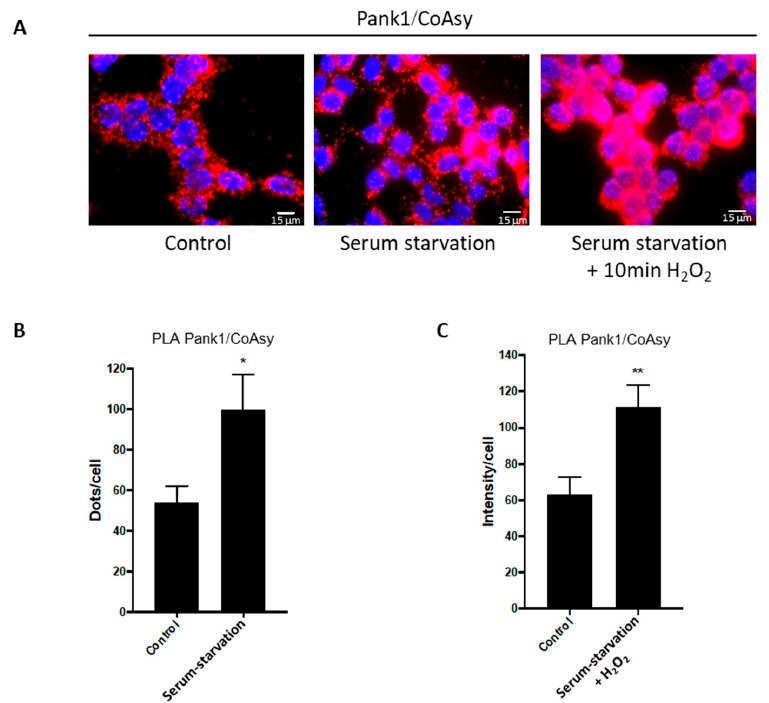
Figure 3. Serum starvation and treatment of HEK293/Pank1 β cells with hydrogen peroxide (H 2 O 2 ) induce the Pank1/CoAsy association in situ. ( A ) Pank1 interaction with CoAsy is significantly increased in HEK293/Pank1 β cells in response to serum starvation (16 h) or serum starvation (16 h) followed by treatment with 500 μΜ H 2 O 2 (10 min). Nuclei are stained with DAPI (blue); proximity ligation assay (PLA) performed for Pank1 and CoAsy (Red). Scale bars: 15 μ m. Images are representative of three independent experiments. ( B ) Relative quantitation of Pank1/CoAsy assembly in control untreated and 16 h serum-starved HEK293/Pank1 β cells from ( A ). Dots/cell counted. Data are presented as mean ± standard error of the mean (SEM) from n = 3 experiments (* p < 0.05). ( C ) Relative quantification of the mean fluorescence intensity per cell for control untreated and serum starved + H 2 O 2 treated cells from ( A ). Data represent mean ± SEM from n = 3 experiments (** p <